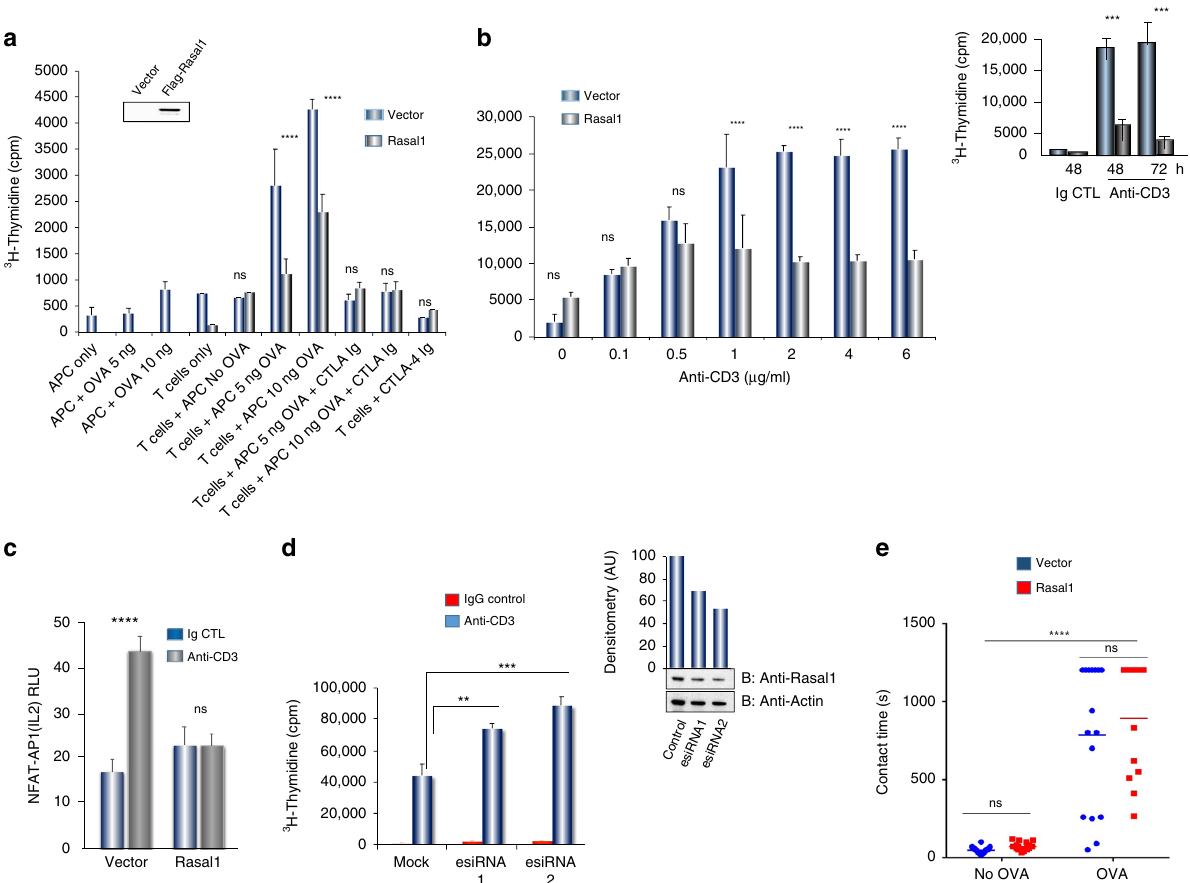
Fig. 5 Rasal1 inhibits in vitro anti-CD3 and dendritic cell-peptide induced T-cell activation. a Antigen (OVA 323-39 )-dependent activation and proliferation of DO11.10 CD4 + cells expressing Flag-tagged Rasal1 compared with control cells at different OVA peptide concentrations (5 – 10 ng). CTLA-Ig was used as a control. Upper inset shows expression of Flag-tagged Rasal using anti-Flag in blotting ( n = 3). b Inhibition of T-cell responses by Rasal1 to increasing anti- CD3 concentrations. Upper inset: effects of Rasal1 at 48 and 72 h post-anti-CD3 activation ( n = 3). c Anti-CD3-driven NFATc1/AP1 promoter activity in Jurkat T cells was inhibited by the presence of Flag-tagged Rasal1 ( n = 3). d siRNA (esiRNA) knockdown of Rasal1 enhances T-cell proliferation. esiRNA were tested for their knockdown ef fi ciency by western blot (top right panel), esiRNA1 and 2 correspond to 500 nM and 1000 nM concentrations ( n = 3). e Contact time between D011.10 CD4 + T-cells expressing Flag-Rasal1 (red) or empty vector (blue) and OVA peptide on bone marrow dendritic cells (BMDCs). Dot blot of T cell/DC contact duration time in presence of OVA was unaffected by Flag-tagged Rasal1 or vector transfection ( n = 3). Representative plots show mean with ± SD. p -value was calculated by unpaired t test. *p < 0.05, ** p < 0.01, *** p <